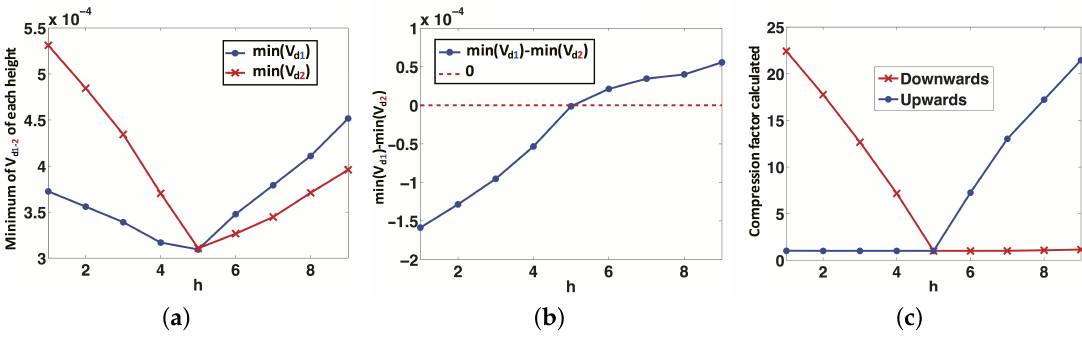
Figure 12. ( a ) Minimum of the vectors (cid:126) Vd 1 (Case 1) and (cid:126) Vd 2 (Case 2). ( b ) Difference between min ( (cid:126) Vd 1 ) and min ( (cid:126) Vd 2 ) . ( c ) The a j factor, which is proportional to the real relative height between each image